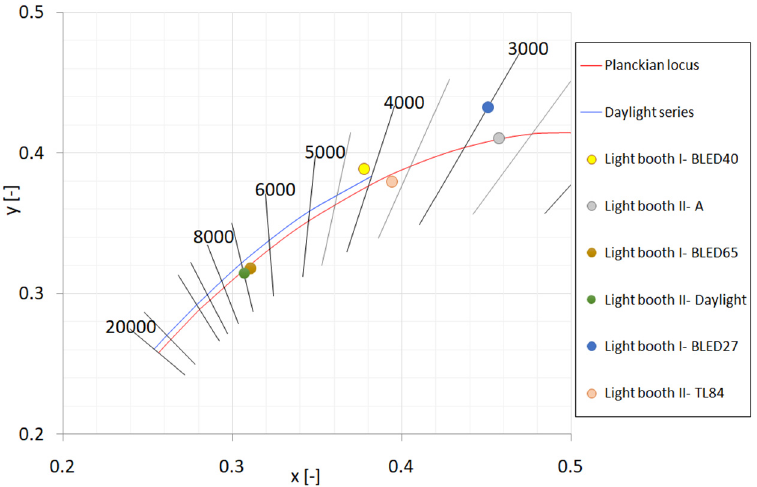
Figure 3. Different positions of the test light sources in the xy chromaticity diagram. In the figure, BLED65, BLED40, and BLED27 represent the light sources with nominal CCT 6500 K, 4000 K, and 2700 K respectively for light booth I; and Daylight (Simulator D65), TL84 (Tri-band fluorescent tube), and A (Tungsten lamp) represent the light sources with nominal CCT 6500 K, 4000 K, and 2700 K respectively for light booth II.